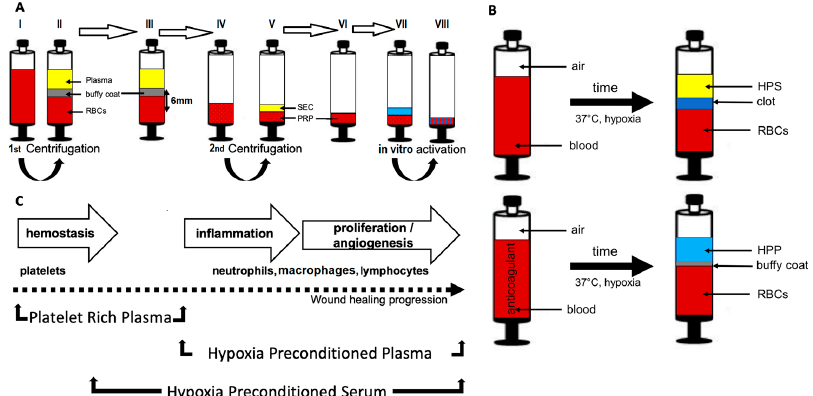
Figure 1. Method of preparation of di ff erent blood-derived secretomes and their correlation with the physiological wound healing phases . ( A ) Preparation of platelet-rich plasma (PRP). Main procedure steps are shown by arrows. (I) Tube with anticoagulant after blood sampling. (II) After 1st centrifugation, blood has been separated into the shown layers. (III) Collection of all content (including the bu ff y coat) above the mark (6 mm), and (IV) transfer to another tube without anticoagulant before re-centrifugation. (V) After 2nd centrifugation, there is a division into serum component (SEC) and PRP. (VI) Separation of PRP (0,5 mL) from the SEC. (VII) Activation of PRP with Thrombin and CaCl 2 , or by CaCl 2 only. (VIII) Activated PRP as a final product (blue dots represent released growth factors in PRP). ( B ) Preparation of hypoxia preconditioned secretomes (HPS, HPP). Blood is allowed to clot (top), or anticoagulated (bottom), and PBCs (in clot or bu ff y coat) are preconditioned under pericellular (local) hypoxia (~1% O 2 ) and physiological temperature (37 o C) for 4 to 7 days. Sedimentation passively separates growth factor-rich hypoxia preconditioned serum (HPS) or hypoxia preconditioned plasma (HPP) from clot or bu ff y coat, respectively, and red blood cells (RBCs) at the bottom ( C ) Overview of the correlation of the two categories of blood-derived secretomes with the key cell types involved in wound healing, and the corresponding wound healing phases. PRP comprises an increased concentration of platelet-derived growth factors, which is naturally achieved during hemostasis through platelet concentration within the fibrin clot, while HPS and HPP mostly comprise hypoxia-induced factors, which are naturally produced by PBCs during the inflammatory and proliferative phases.